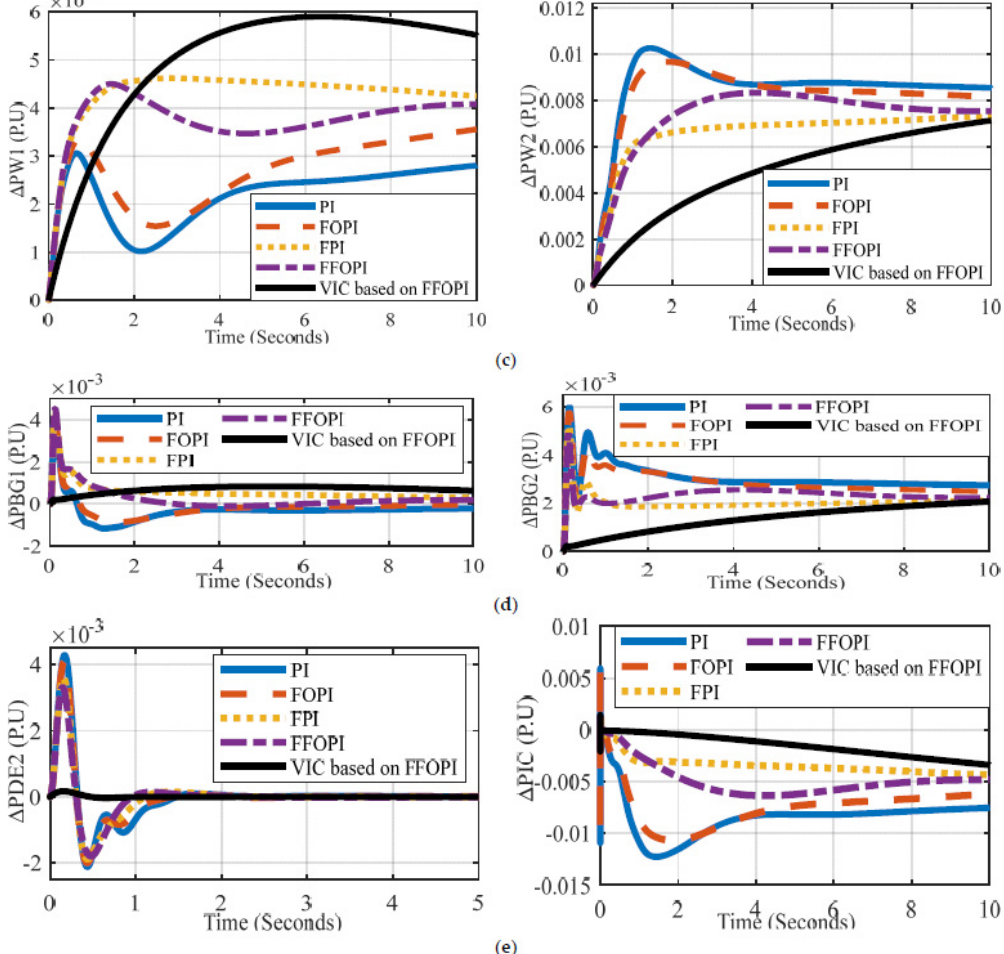
Figure 13. M 1 and M 2 ‘’s active power measurements versus time for each controller at wind speed disturbance: ( a ) ∆ P PV1 (PU), ∆ P PV2 (PU), ( b ) ∆ P total 1 (PU), ∆ P total 2 (PU), ( c ) ∆ P w1 (PU), ∆ P w2 (PU), ( d ) ∆ P BG1 (PU), ∆ P BG2 (PU), ( e ) ∆ P DE2 (PU), ∆ P IC